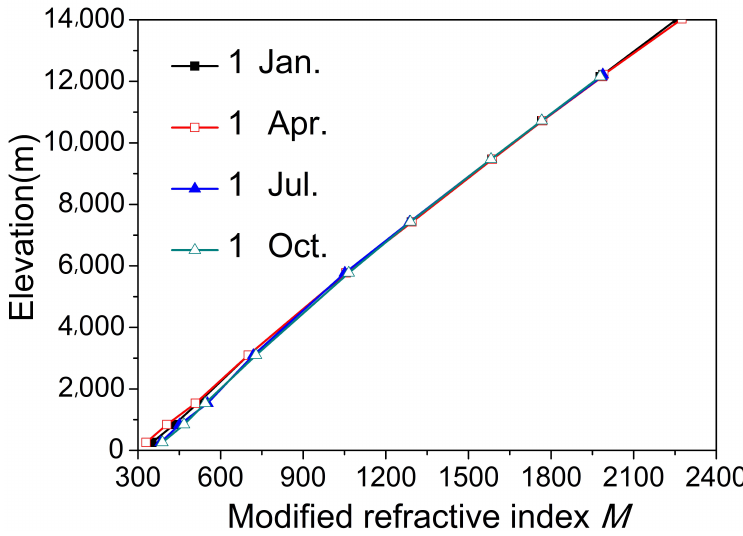
Figure 2. The modified refractivity caused by the curvature of the